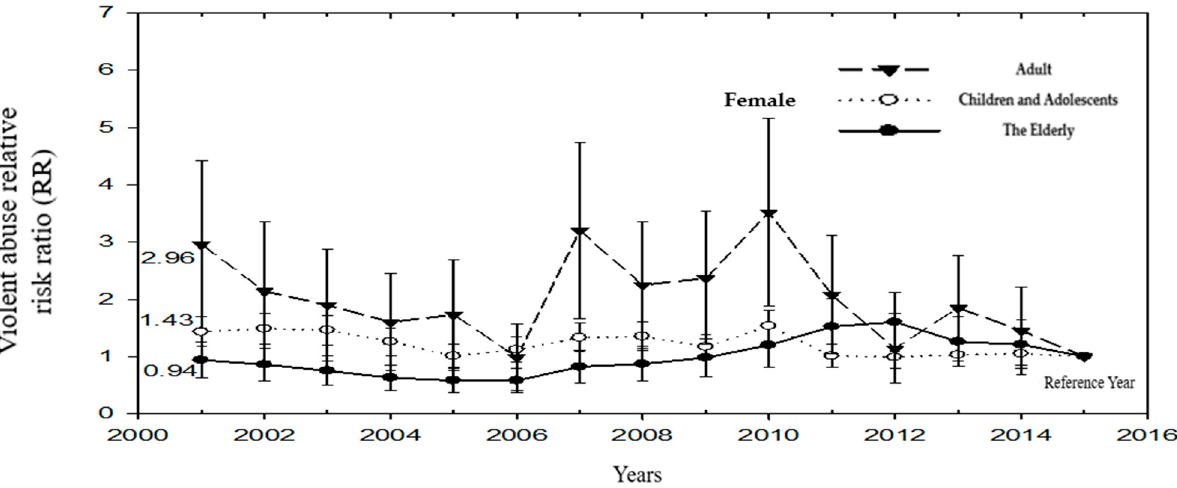
Figure 5. The relative hazard ratio (RR) of seeking medical treatment for violence in children, adults, and the elderly over the years (Female) (Reference group: 2015).